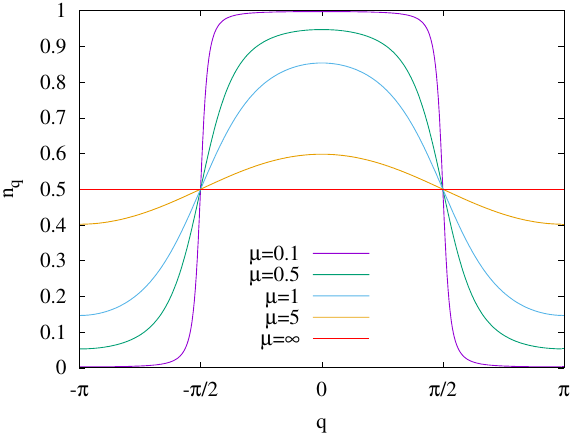
Figure 3: Occupation numbers (46) for various values of µ .